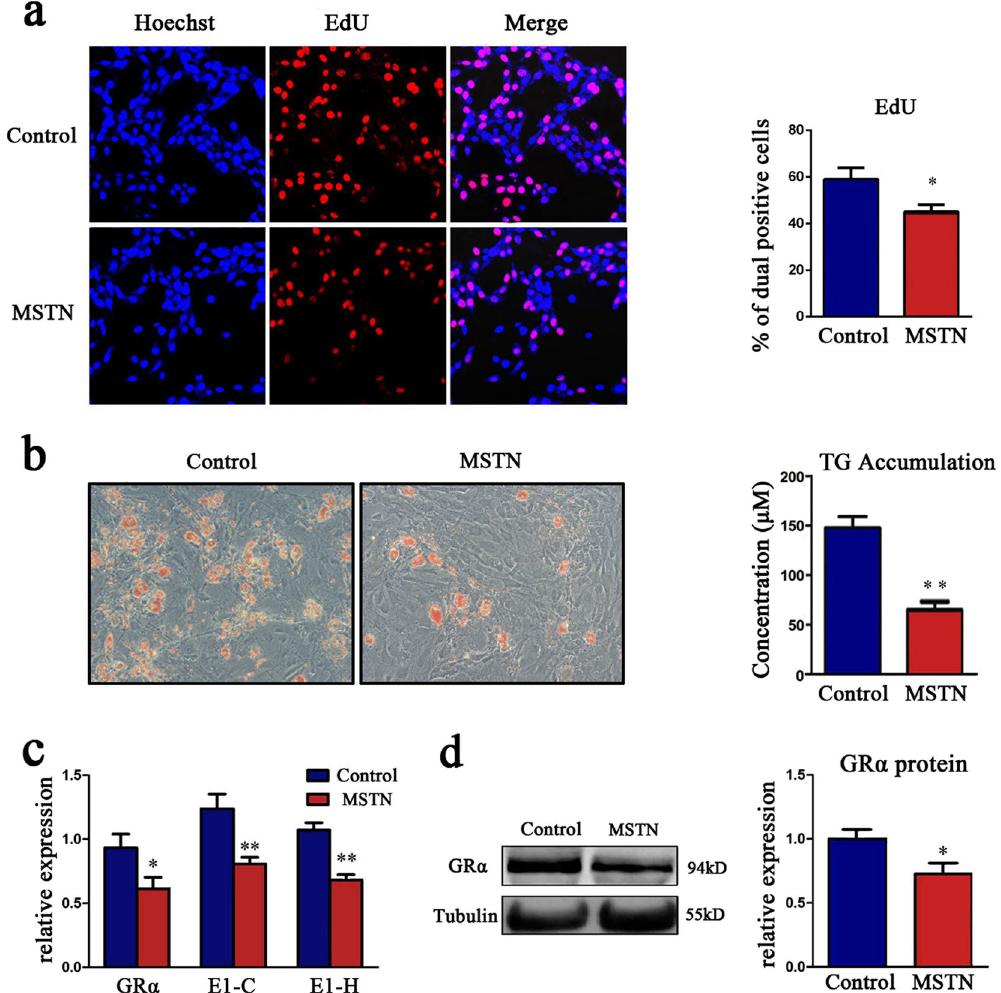
Figure 5. MSTN inhibited adipogenesis and reduced GR α expression. ( a ) The effects of MSTN on the proliferation of subcutaneous pre-adipocytes. Pre-adipocytes were treated with 50 ng/ml MSTN for 2 days, then the proliferating nuclei were stained red with EdU for 2 hours, and nuclei of all cells were stained blue with Hoechst (left). Three random pictures per group from confocal microscopy were used to count the cell numbers of EdU positive cells and Hoechst positive cells, and the ratio of the EdU positive cells to Hoechst positive cells was calculated in each picture (right). ( b ) Oil red O staining (left) and TG assay (right), n = 3 per group. The pre-adipocytes were cultured in culture medium until full confluence, then the cells were induced to differentiation with PBS or 50 ng/ml MSTN for 9 days. ( c ) The mRNA expression of GR α , exon 1C and 1H was detected by RT-qPCR, n = 6 per group. ( d ) The protein expression of GR α was detected by Western blot (left) and displayed as column charts after quantification (right), n = 3 per group. * P < 0.05; ** P <